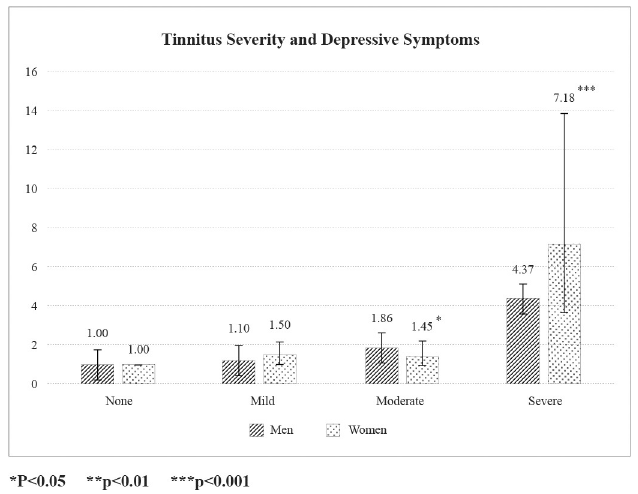
Fig 1. Association between tinnitus severity and depressive symptoms, stratified by sex.